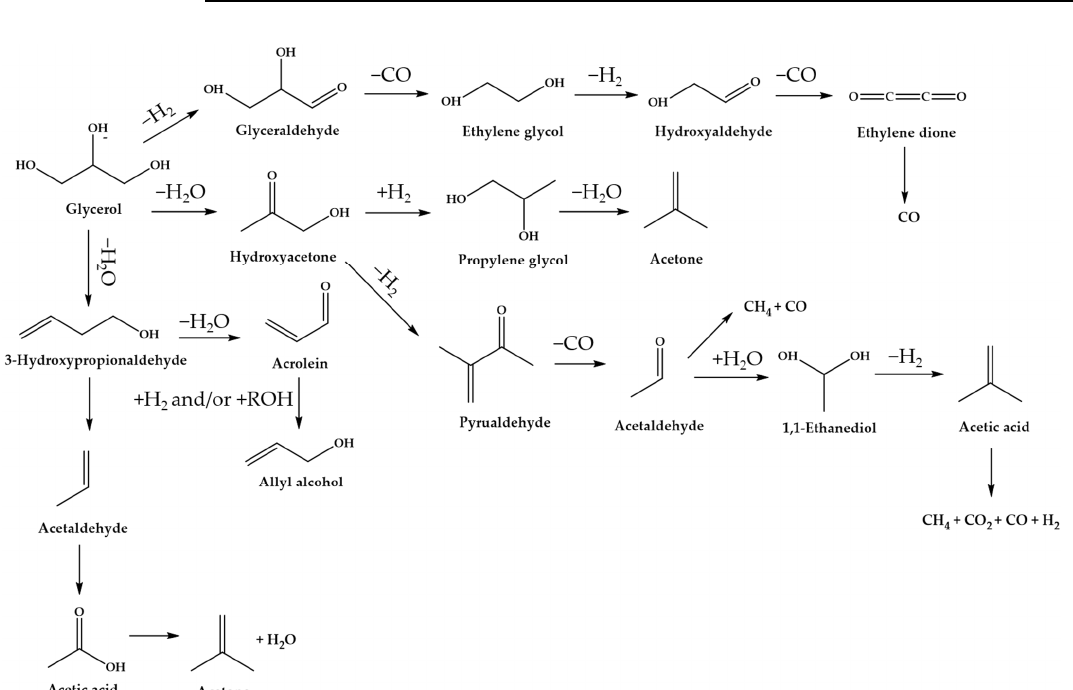
Figure 2. The reaction mechanism for steam reforming of glycerol [34]. Steam reforming is regarded as the most promising approach to produce H 2 from glycerol, and the reactions involved are shown below: